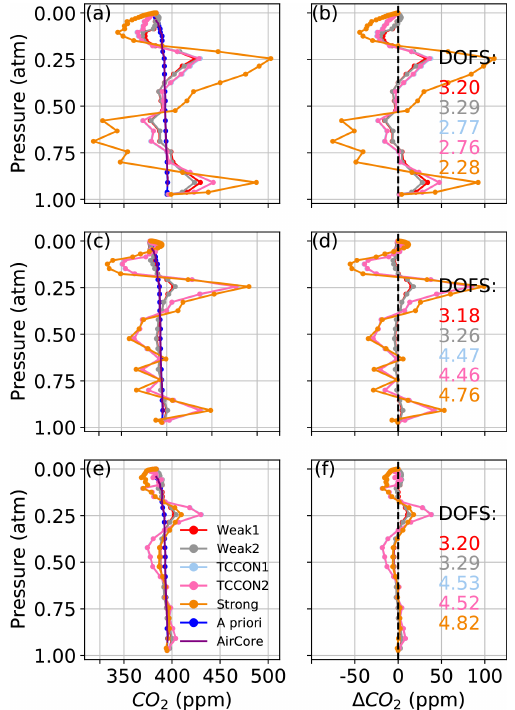
Figure 7. The left-hand panels show CO 2 profiles retrieved using synthetic spectra. In (a) the air- and self-broadened half-width co- efficients of all CO 2 lines is increased by 0.1%. In (c) the temper- ature dependence of these coefficients is decreased by 1%. In (e) , the synthetic spectrum used as “measurement” is generated with the speed-dependent Voigt line shape with line mixing, but profiles are retrieved using a Voigt line shape. Panels (b) , (d) , and (f) show the difference between the retrieved profiles and AirCore, correspond- ing to (a) , (c) , and (e)